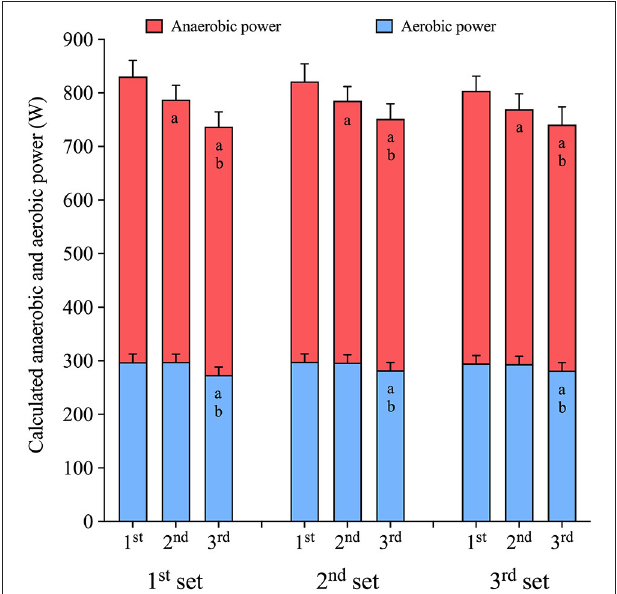
FIGURE 2 | Anaerobic and aerobic mean power output during repeated sets of 3 × 30-s maximal sprints using the GE-method. Sprints were interspersed by 4min recovery and performed during a 3-h prolonged cycling session riding at a power output equivalent to 50% ˙ VO 2max . Data are mean ± 95%CI, n = 12. a indicates significant difference from the first sprint ( p < 0.05). b indicates significant difference from the second sprint ( p < 0.05).